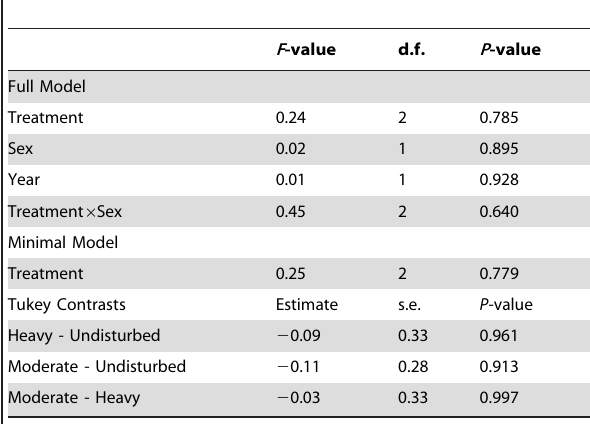
Table 4. Results of a linear mixed model for nestling body condition.